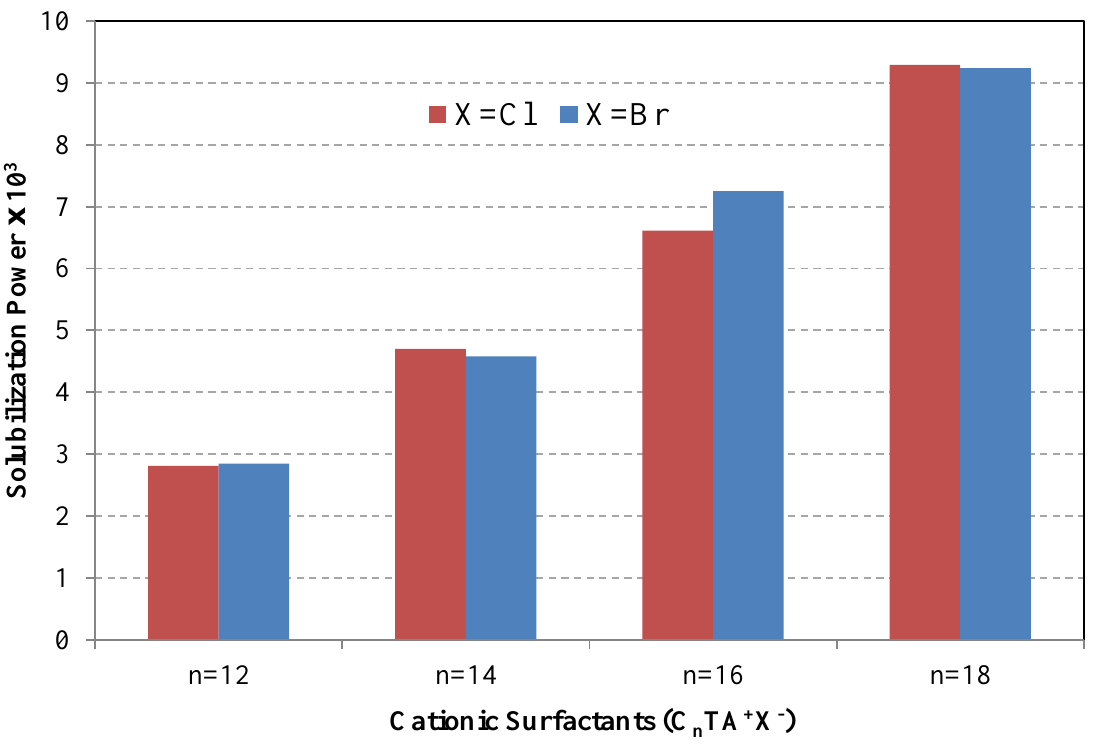
of cationic surfactants (C from